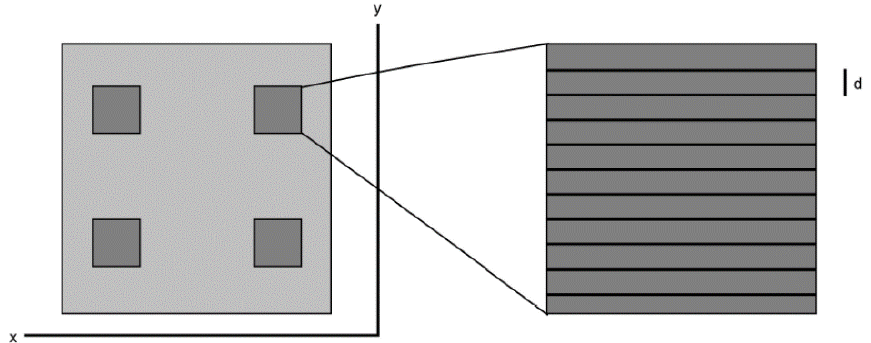
Figure 2. Schematics of the laser-structuring of a flat sample. The sample has four laser-processed areas (shown as darker squares). Each processed area was scanned line-by-line, resulting in a meander-pattern with a line distance d.